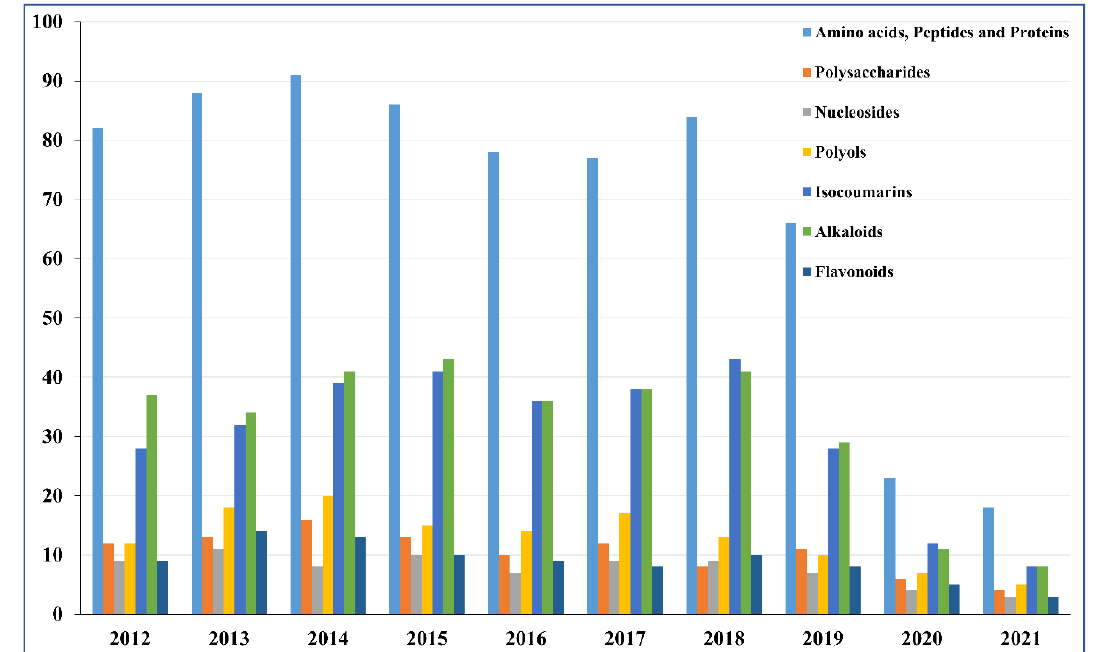
Figure 1. The summary of the number of works on different chemical components in the family Blattidae in past years.